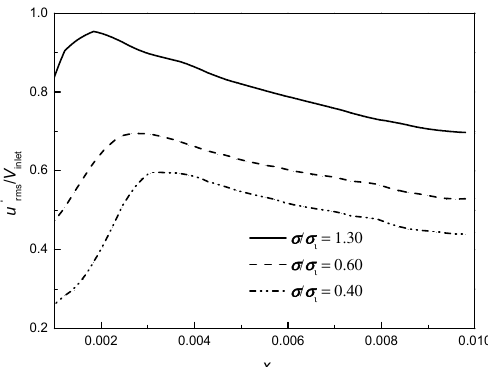
Figure 7. Root mean square value of the fluctuating velocity normalized by the inlet flow velocity, u (cid:48) rms / V inlet , at di ff erent distances, x , from the trailing edge of the hydrofoil along a horizontal line for free cavitation and cavitation conditions.